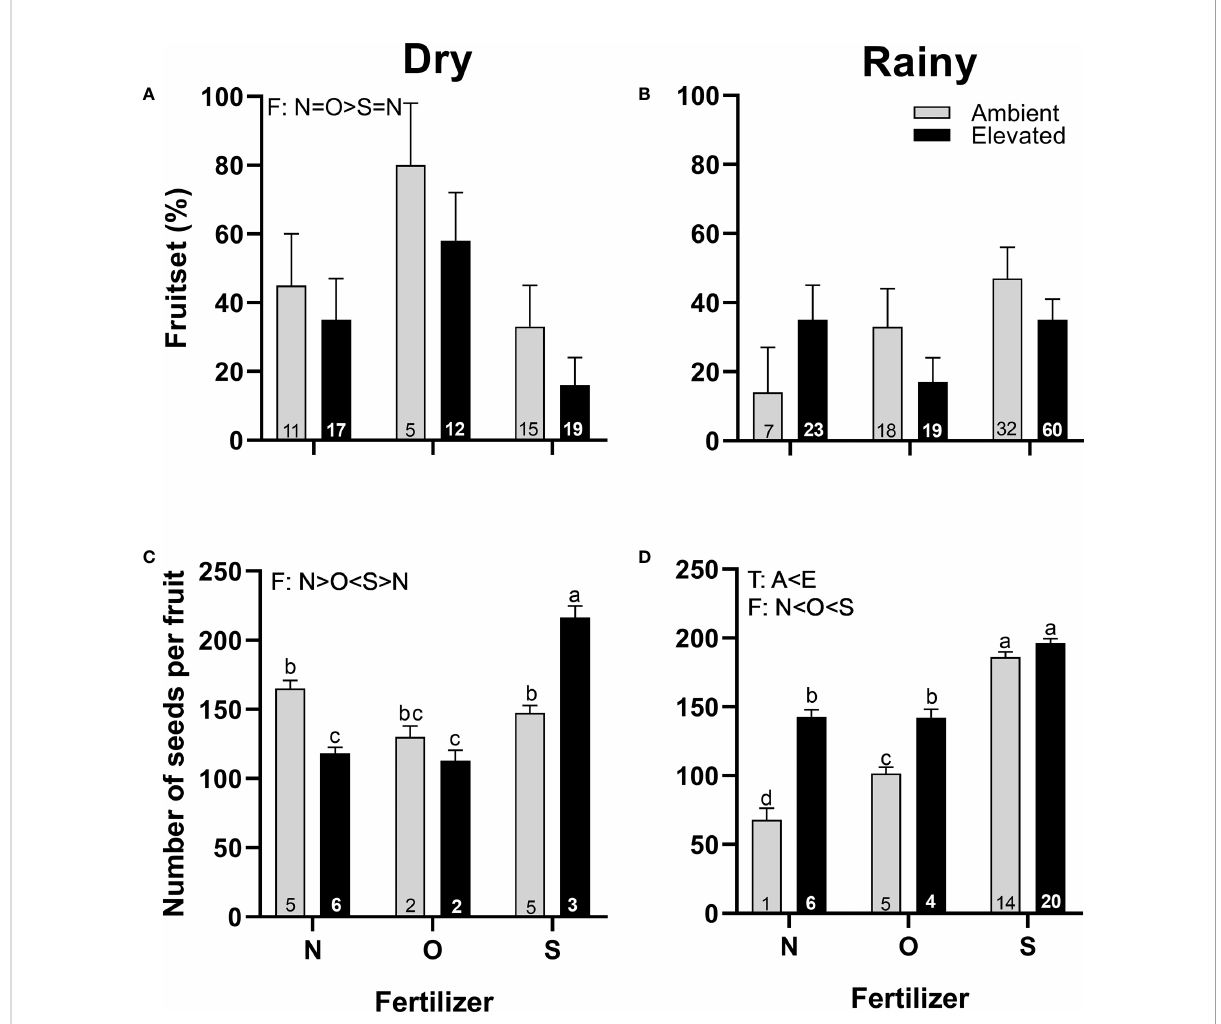
FIGURE 8 Effects of the increase in temperature (T) and addition of fertilizer (F) on fruit set (A, C) and the number of seeds per fruit (B, D) of C. pepo during the dry (left) and the rainy (right) season (mean ± SE; n: number inside bar). Signi fi cant differences in the main factors (T or F) are represented with capital letters (A, ambient temperature; E, elevated temperature; N, no supplementary fertilizer; O, organic fertilizer; S, synthetic fertilizer). Different lower-case letters above bars indicate statistically signi fi cant T x F interactions. Mean and standard deviation values are in Supplementary Tables 1, 2 and the results of the statistical tests are summarized in Supplementary Table